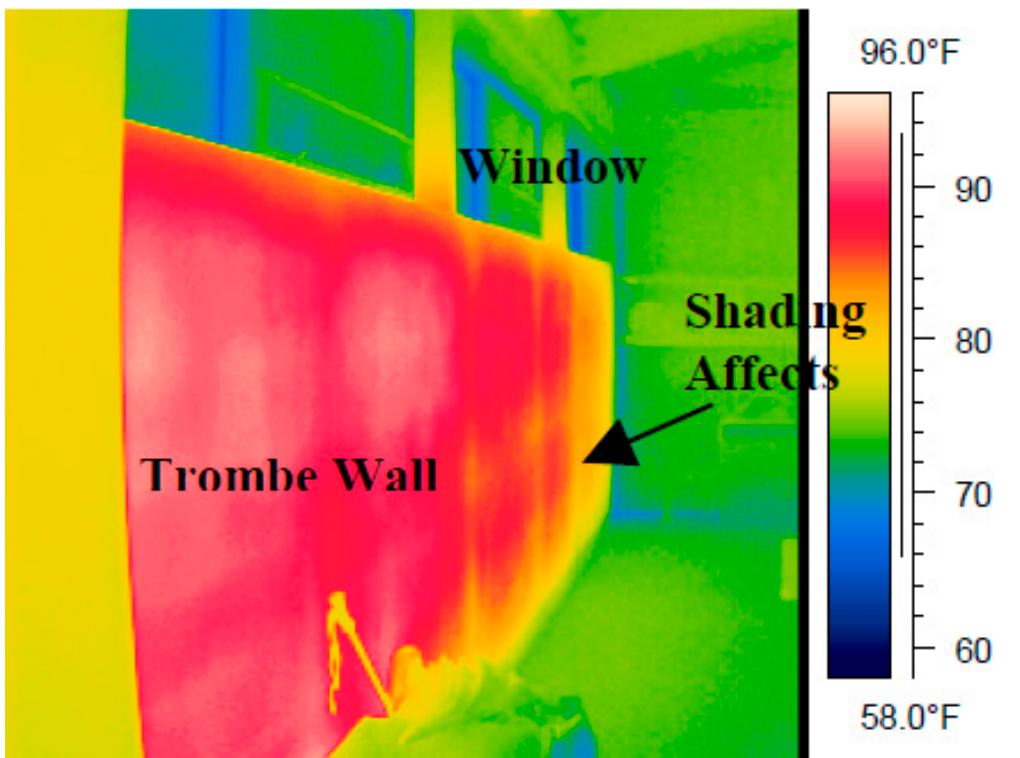
Figure 3. Thermal distribution of the Trombe wall in December (data from ref. [55]).